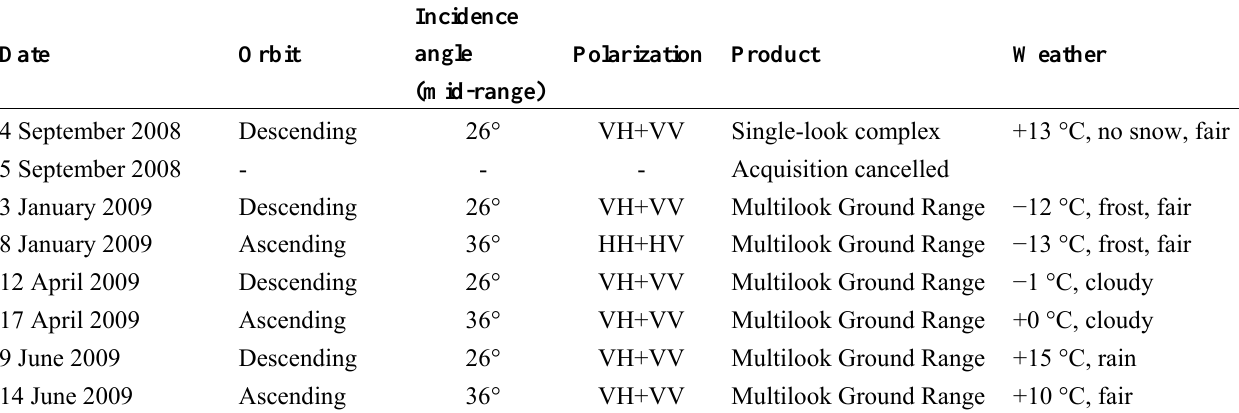
Table 2. TerraSAR-X Stripmap images acquired from the test